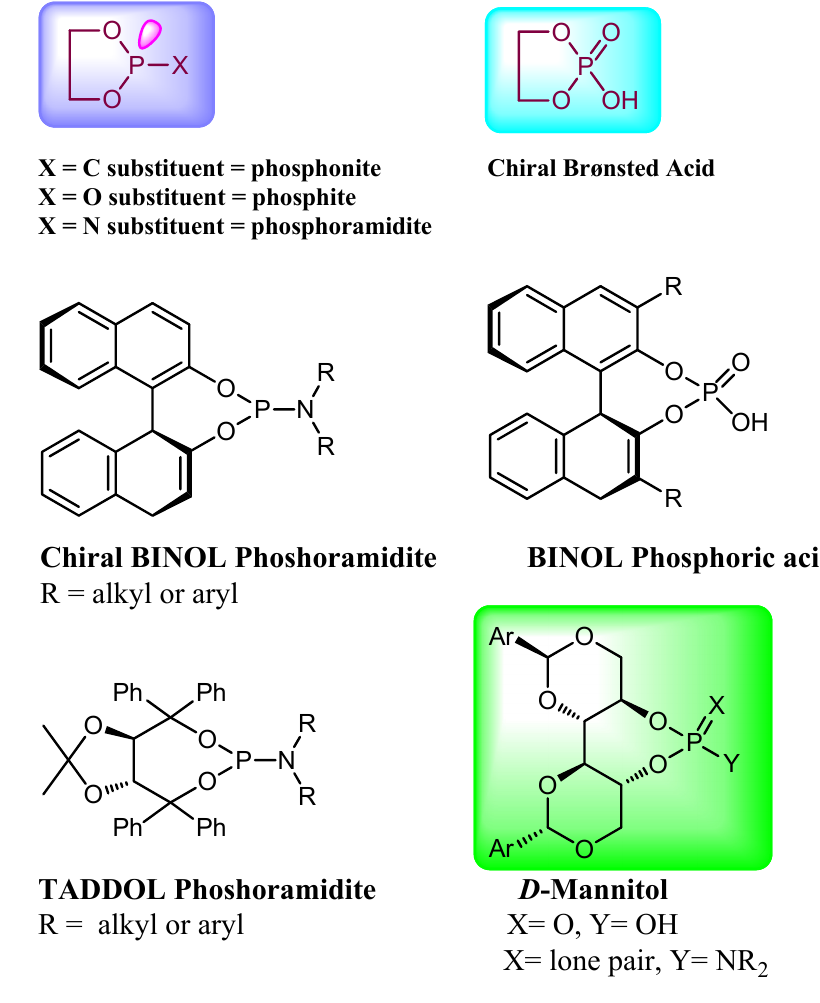
Figure 1. Chiral phosphoramidite ligands and Brønsted acid derived from BINOL or TADDOL